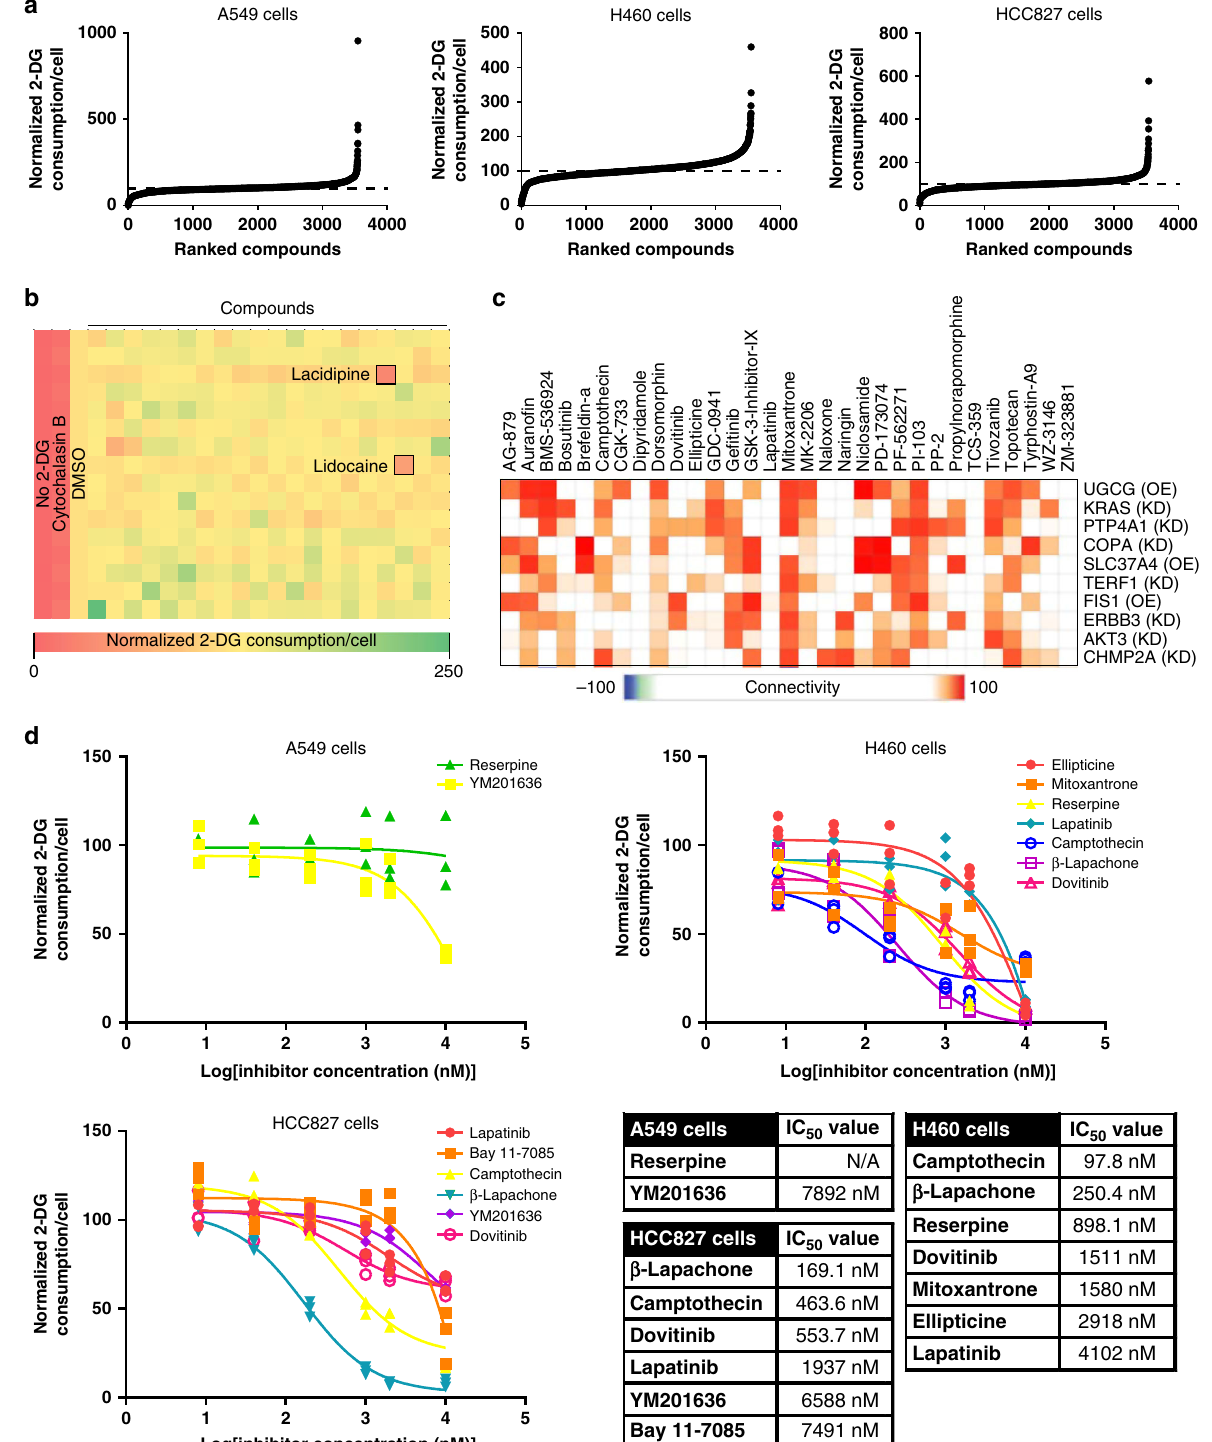
Fig. 2 A high-throughput screen identi fi es inhibitors of NSCLC glucose consumption. a Waterfall plots of glucose consumption in A549, H460, and HCC827 cells treated with one of 3555 small molecule inhibitors. n = 1. b Example heat map of glucose consumption from a 384-well plate of H460 cells treated with small molecules from the NIH clinical collection. c Genetic alterations connected to the small molecules we identi fi ed as inhibitors of glucose consumption. Analysis performed using the Connectivity Map. OE overexpression, KD knockdown. d Glucose consumption dose response curves and values for a subset of the compounds identi fi ed in the high-throughput screen. Reserpine in A549 cells is used as a negative control. n = 3 per concentration except n = 2 for H460 cells treated with